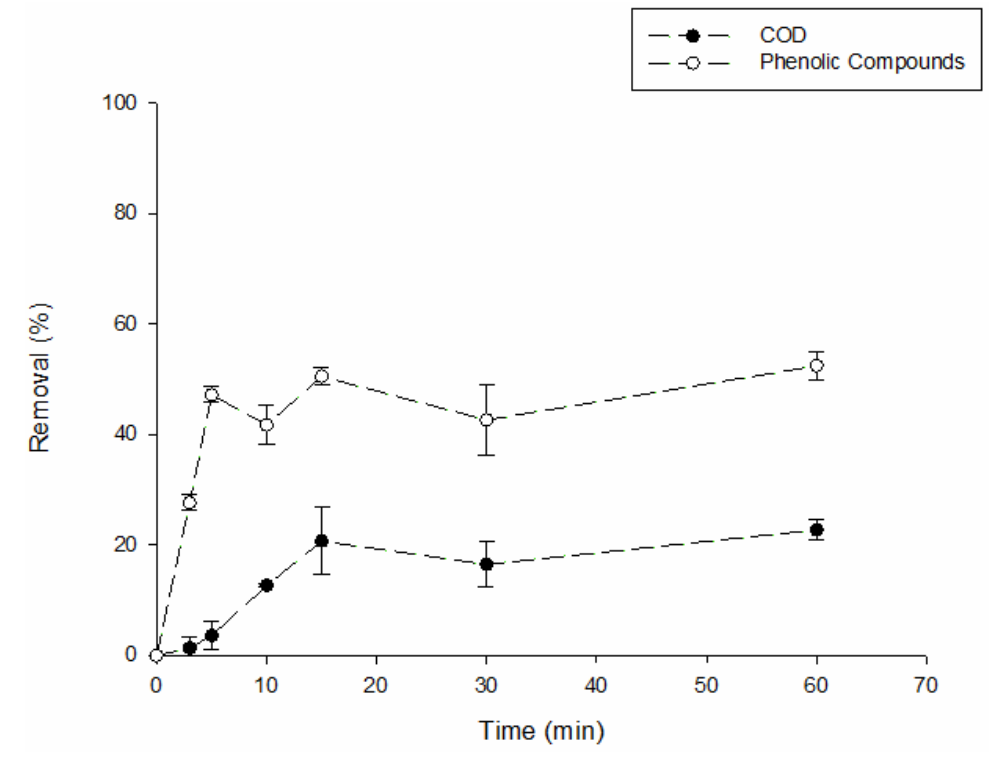
Figure 6. Time influence on COD and phenolic compounds removal in study PMS activated by US (pH = 3 and [PMS] = 1600 mg/L). (pH = 3 and [PMS] = 1600